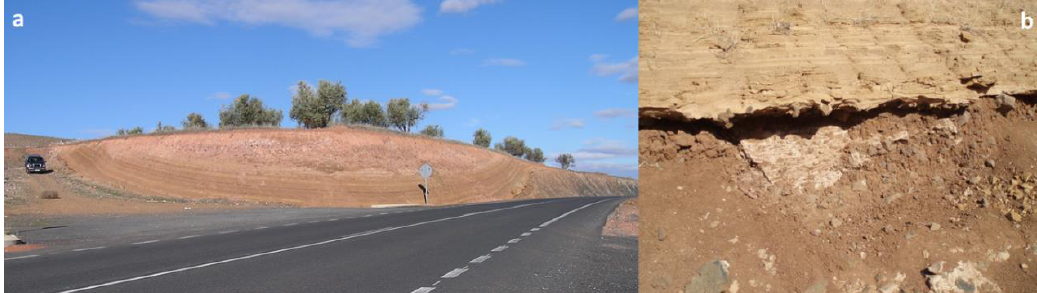
Figure 3. ( a ) Pyroclastic flow deposits on the Columba volcano; ( b ) detail of the deposits of pyroclastic density currents (base surges), paleosoil and vegetable molds.